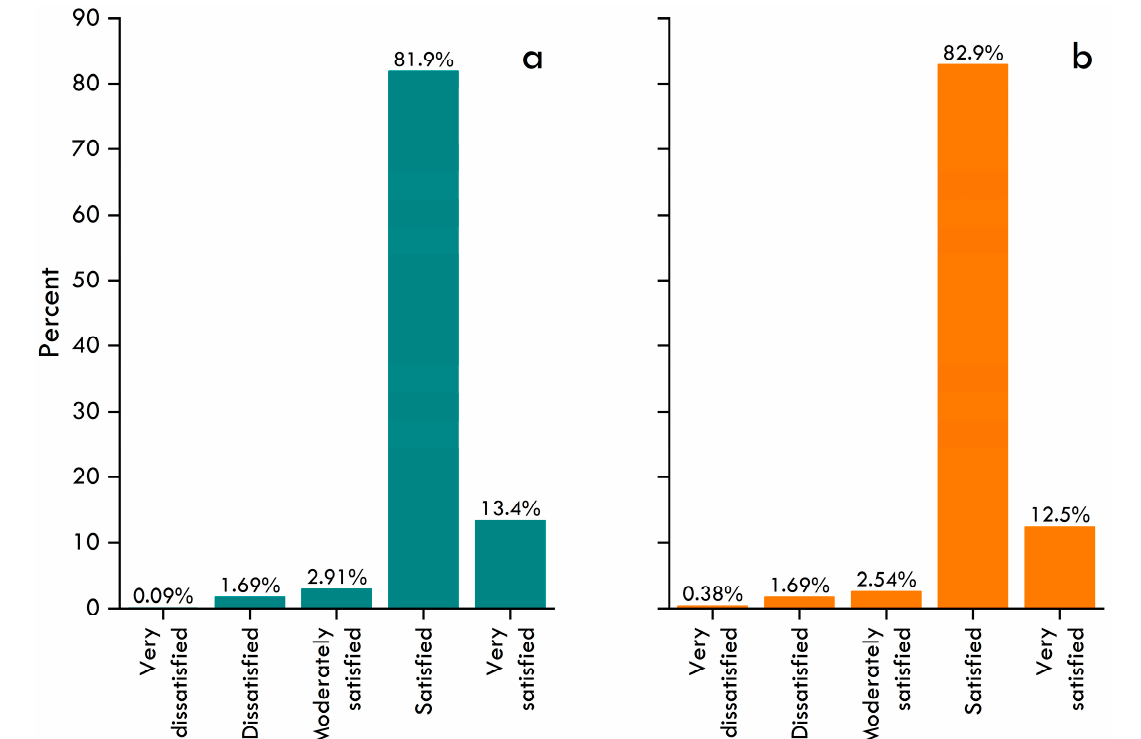
Figure A1. Satisfaction level of respondents ( a ) with waste disposal management services; ( b ) with waste collection and disposal infrastructure. Source : variables are based on our survey data.